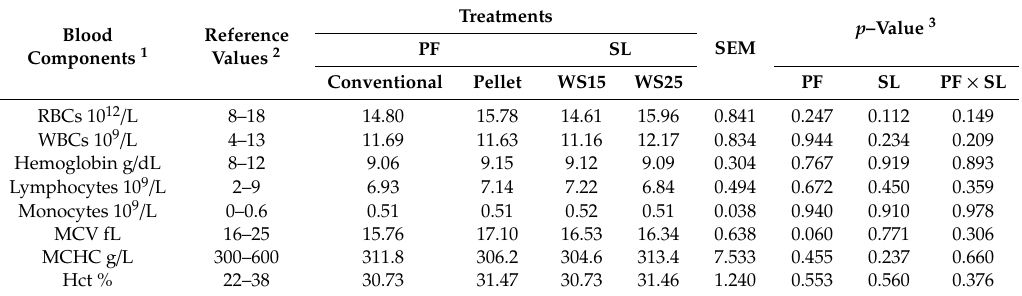
Table 8. Complete blood count components of fattening goats fed conventional and pelleted total mixed rations with two di ff erent levels of wheat